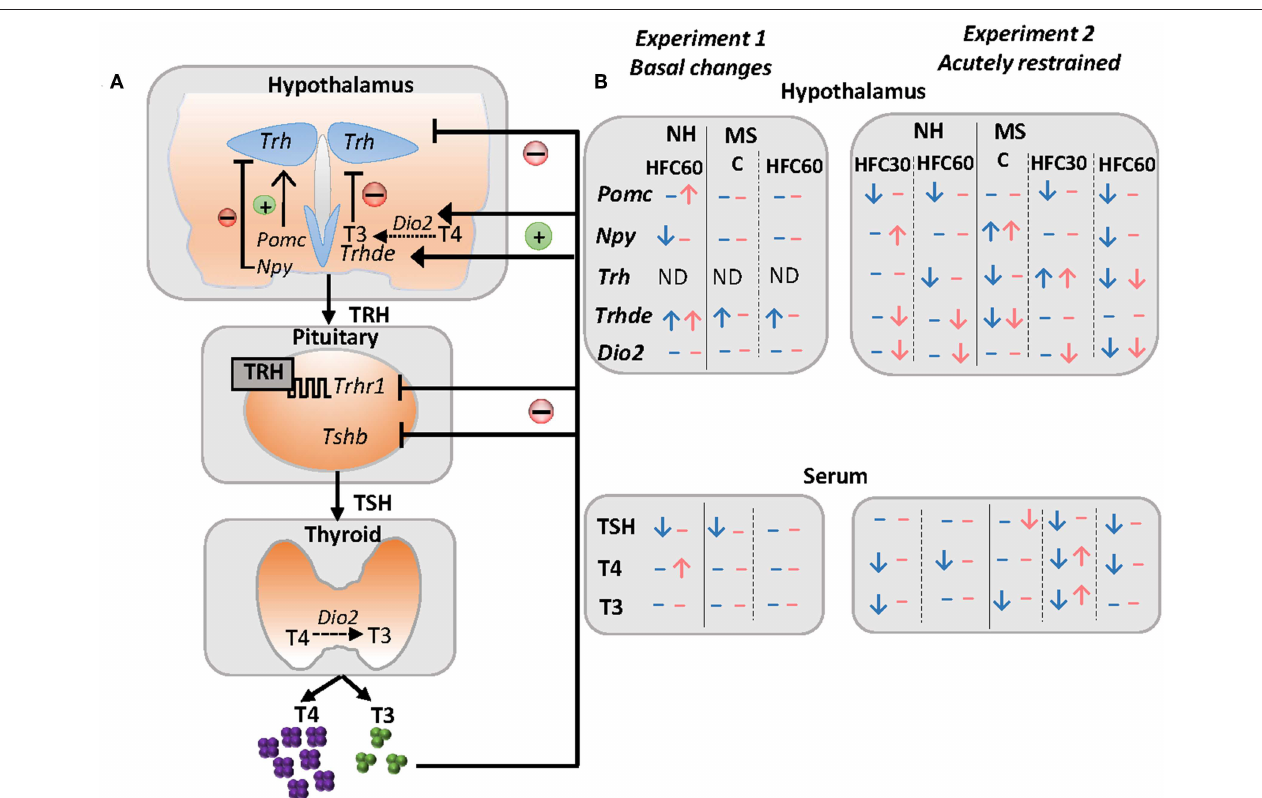
FIGURE 5 | Schema of some peripheral inputs regulating the HPT axis and summary of changes of the HPT axis parameters and arcuate neuropeptides in response to maternal separation and 1–4 months of a high-fat/high-carbohydrate diet under basal conditions or after an acute stress in adult rats. (A) The HPT axis is controlled by thyrotropin-releasing hormone (TRH), synthesized in neurons of the hypothalamic paraventricular nucleus (PVN), and released at the median eminence near portal vessels that communicate with the anterior pituitary, where TRH activates its receptor (TRH-R1) increasing synthesis and release of thyrotropin (TSH) that controls the synthesis of thyroxine (T4) at the thyroid; T4 is converted to 3,3 ′ ,5-triiodo-L-thyronine (T3) by tissue deiodinases I or II (D1, D2). Released TRH at the median eminence may be degraded by the TRH-degrading ectoenzyme (TRH-DE) present in tanycytes before it travels to the pituitary, regulating the amount of TRH that reaches the thyrotrophs, and concomitantly, TSH and thyroid hormone synthesis and release, which in turn exert negative feedback at the pituitary and hypothalamus level. In addition, hypophysiotropic TRH neurons are negatively regulated by arcuate orexigenic neuropeptide Y (NPY), whereas anorexigenic neuropeptide pro-opiomelanocortin up-regulates Trh expression in the PVN. (B) Results summary of experiments 1 and 2. In experiment 1, we evaluated changes in maternal separated rats (MS) fed regular chow (C) vs. non-handled (NH), and the effect of 1 month of a high-fat/high-carbohydrate (HFC60) diet on NH and MS rats administered at Pd60. In experiment 2, we evaluated changes in NH and MS acutely restrained adult rats fed a C or an HFC diet starting at puberty (HFC30) or adulthood (HFC60) until postnatal day 160. NH and MS rats had free access to chow (C) or to an HFC diet from Pd30 or 60 until Pd160 and were restrained for 1h before they were killed. Blue arrows and dashes represent males and pink denotes female rats; arrows indicate changes observed in NH-HFC30 and NH-HFC60 rats compared to the NH-C group; MS-C vs. NH-C; MS-HFC30 and MS-HFC60 compared to MS-C.